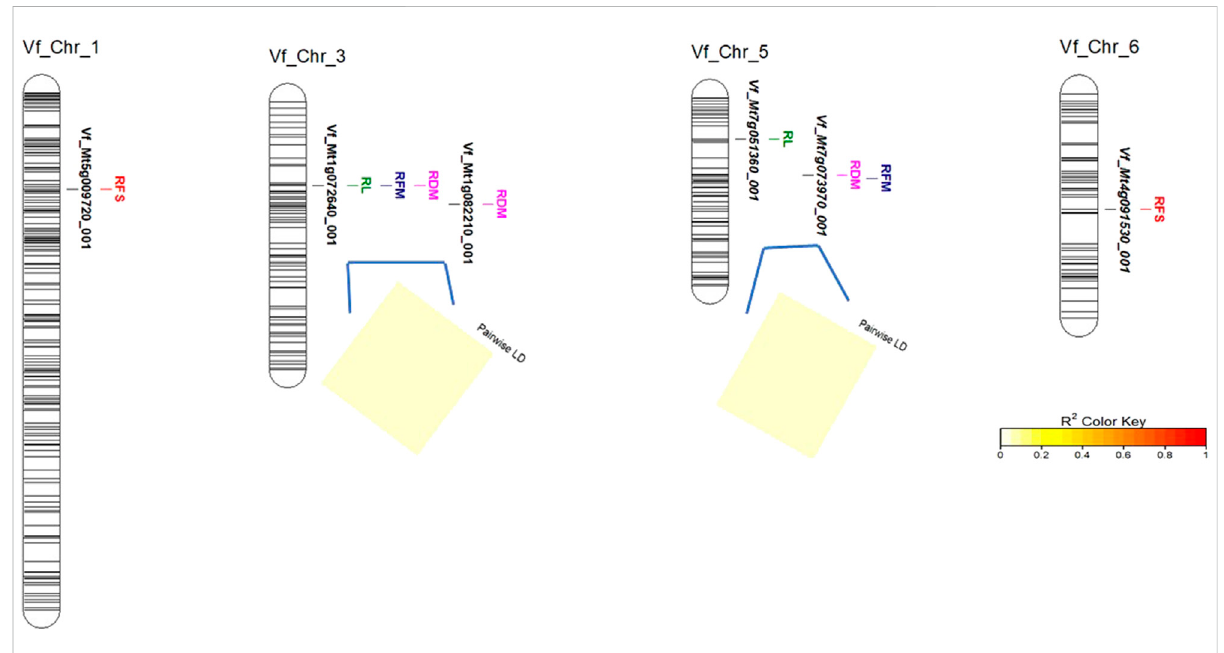
FIGURE 5 Distribution of QTLs associated with root traits detected by the GWAS and LD analysis ( r 2 ) between SNPs located on the same